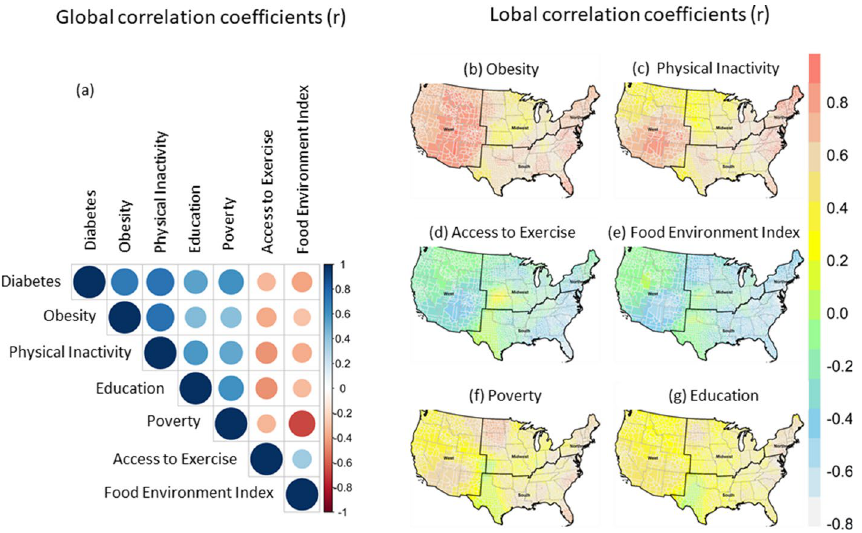
Figure 4. Global ( a ) and local Pearson correlation coefficients ( r -values) of T2D prevalence and six risk factors. ( b ) obesity; ( c ) physical inactivity; ( d ) access to exercise; ( e ) food environment index; ( f ) poverty; and ( g ) education. Maps were created in the R (version 4.0.0) Statistical Computing Environment 39 .